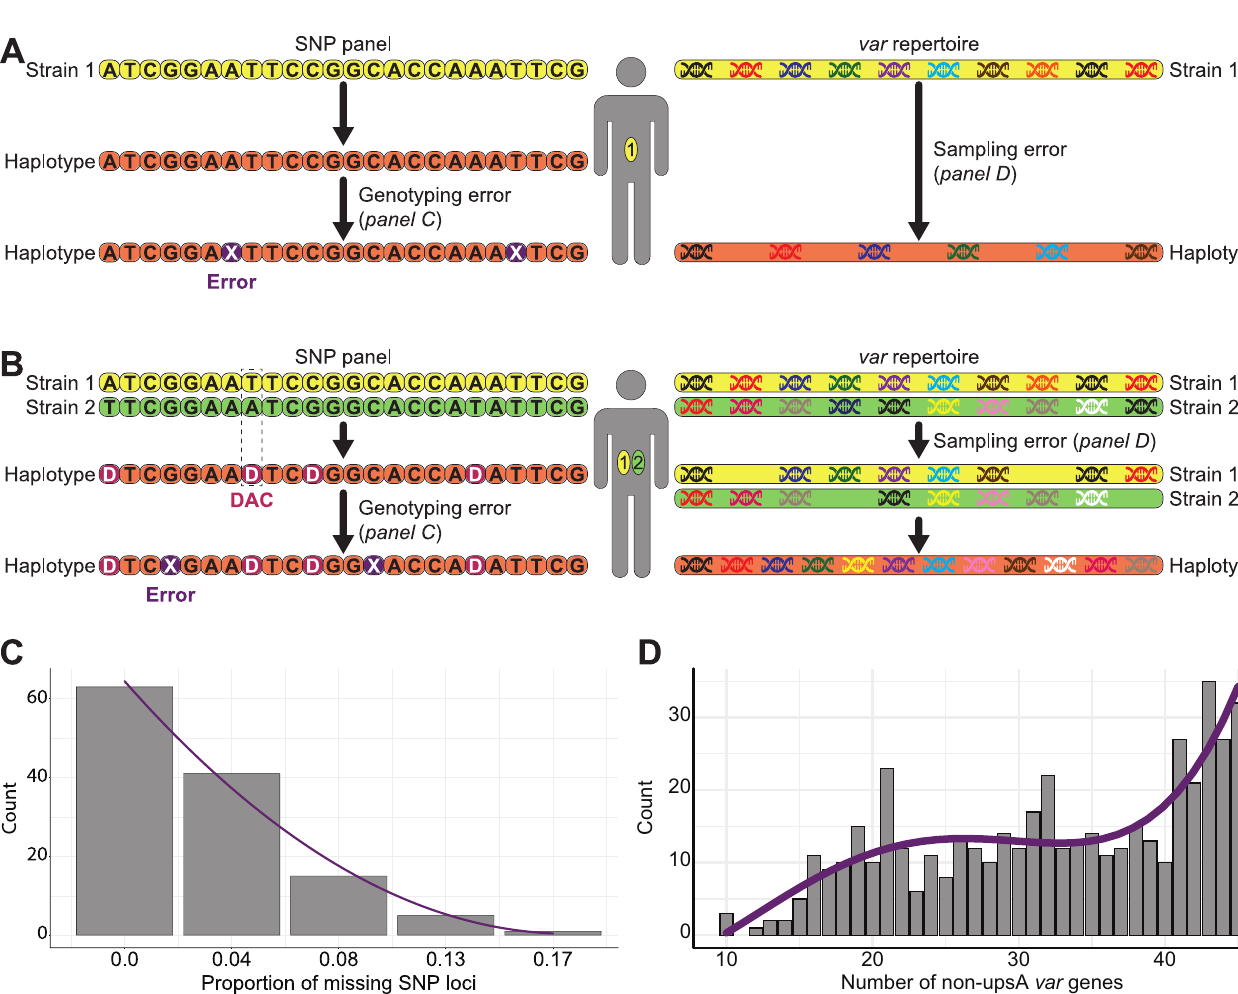
Fig 2. Measurement models. A) and B) Schematic diagrams of the SNP and var measurement models for a host infected by one (MOI = 1) or two (MOI = 2) genetically distinct P . falciparum strains, respectively. To account for potential SNP genotyping failures, we randomly replaced the host genotypes with missing data (X). This replacement was implemented by using the distribution illustrated in panel C. When MOI is high, the frequency of double allele calls (DACs) is also high (Figs 3 and S3). To account for var gene potential sequencing errors, we sub-sampled the number of var genes per repertoire. This sub-sampling was implemented by using the distribution illustrated in panel D. For simplicity, the var repertoire in these two examples only consists of 10 var genes despite each migrant parasite genome consists of a repertoire of 45 var genes in the simulations (S1 Table). C) Histogram of the proportion of missing SNP loci per host haplotype from a panel of 24 bi-allelic SNP loci. The genotypes were previously obtained from monoclonal infections sampled during one cross-sectional survey made in 2015 in the Bongo District, in northern Ghana. The purple curves show the best curves that fit the data using the adjusted R-squared. D) Histogram of the number of non-upsA (i.e., upsB and upsC) DBL α var gene types per repertoire. The molecular sequences were previously sequenced from monoclonal infections, i.e., hosts infected by a single P . falciparum strain (MOI = 1), sampled during six cross-sectional surveys made from 2012 to 2016 in the Bongo District, in northern